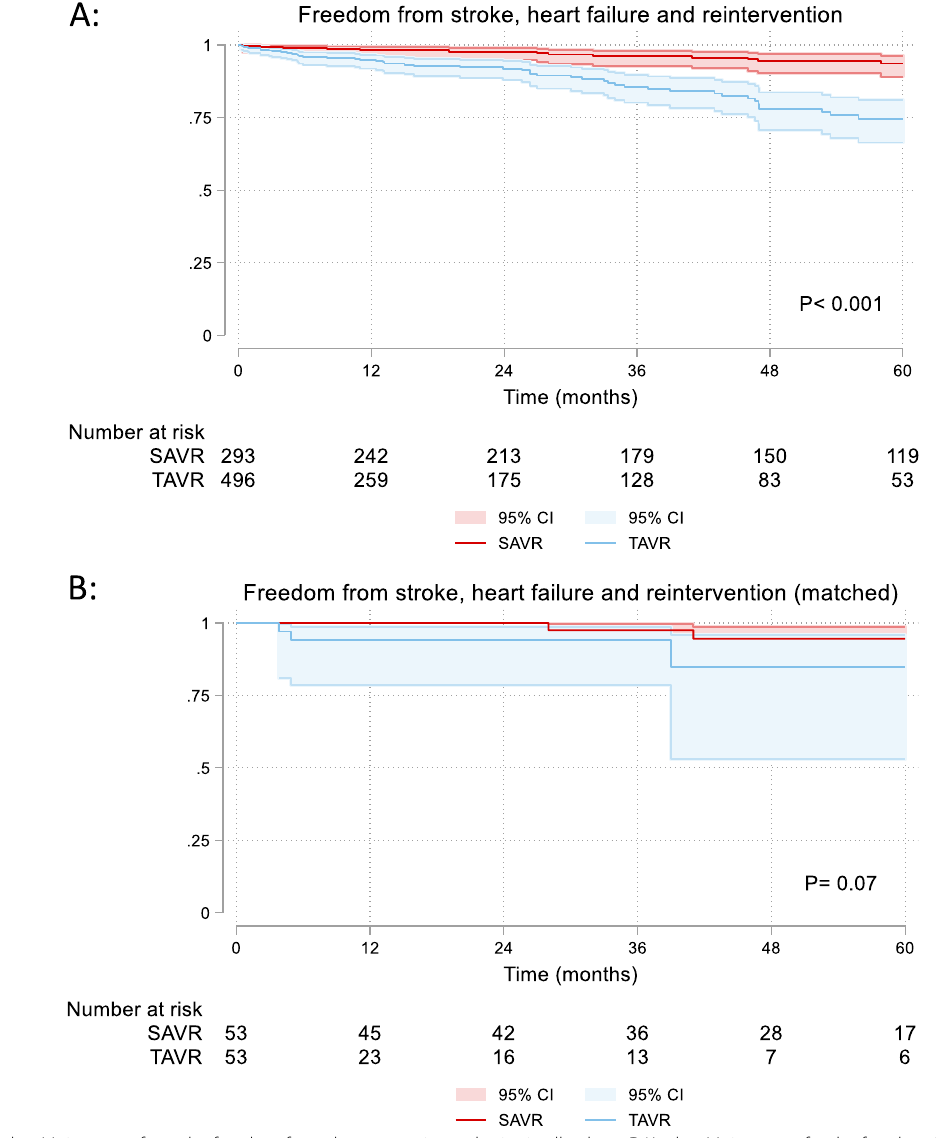
Fig. 2 A Kaplan-Meier curve from the freedom from the composite endpoint in all cohort. B Kaplan-Meier curve for the freedom from the composite endpoint after matching (SAVR, surgical aortic valve replacement; TAVR, transcatheter aortic valve